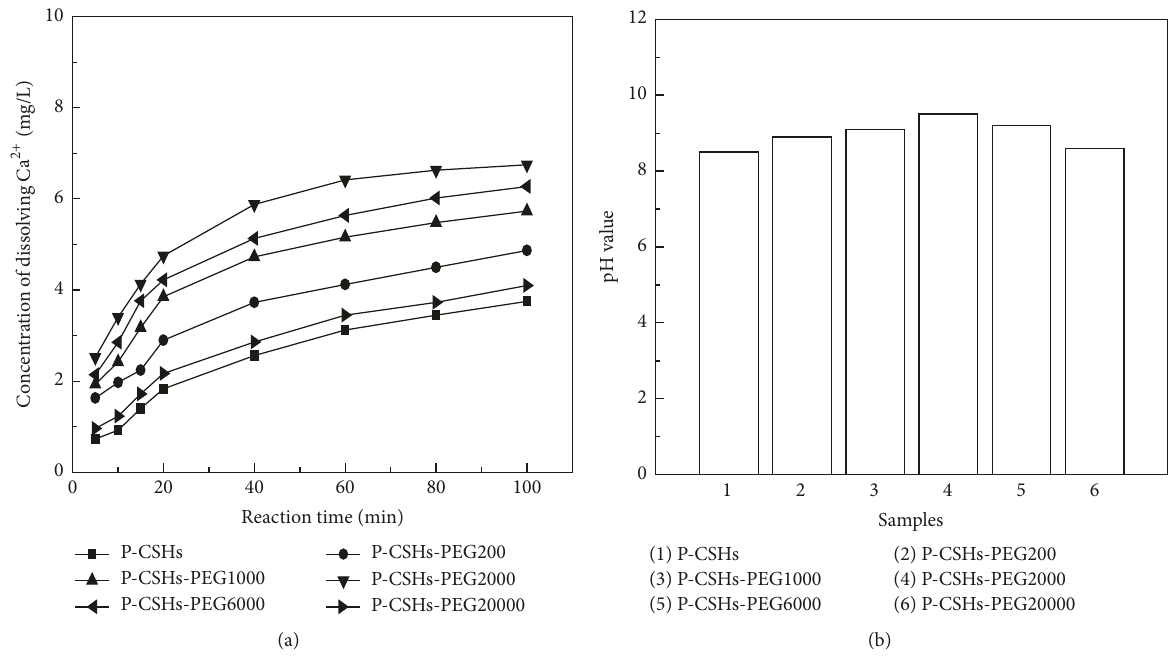
Figure 5: (a) The variation of dissolved Ca 2+ concentration for different samples; (b) the variation of pH value in